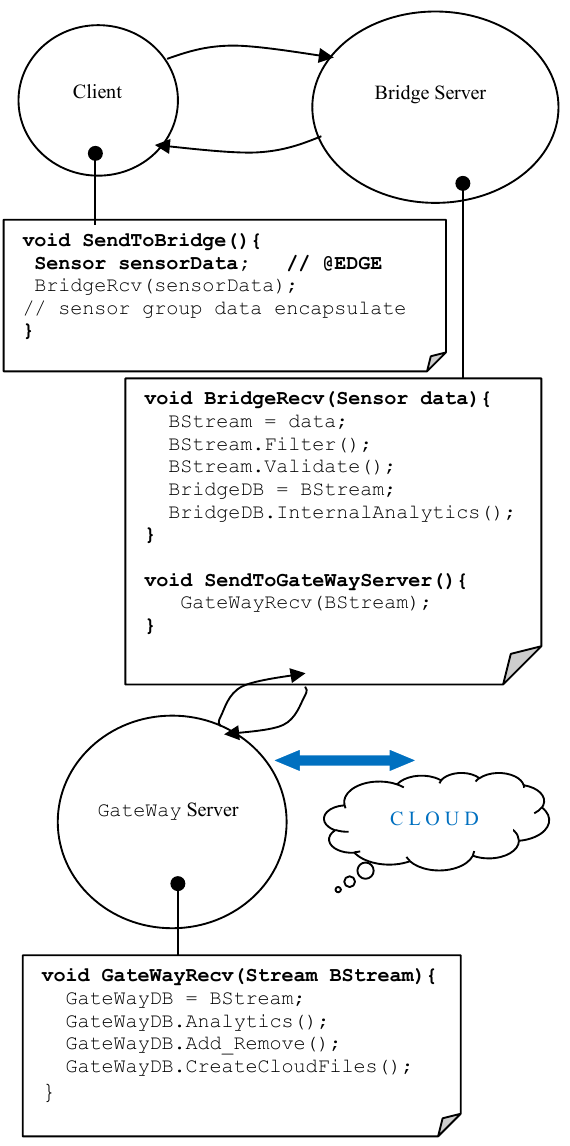
Fig. 3. Lightweight IoT clients and visitor functions. Code level implementation of a 5-level lightweight communication